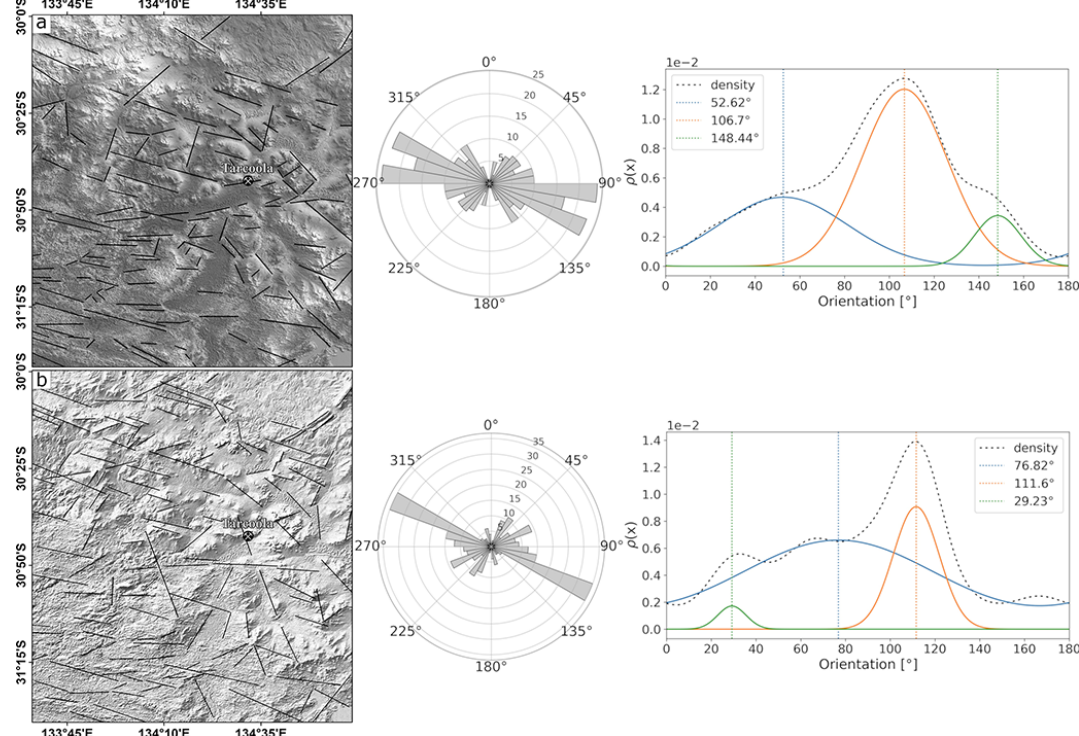
Figure 7. (a) Manually segmented lineaments observed in the unprocessed laser altimeter DEM data. To the right of the map the rose diagram showing the distribution of strike directions (bin size of 10 ◦ ) and the Gaussian model fitted to the probability density function is shown. (b) Manually segmented lineaments obtained from the laser altimeter data after edge detection filtering. We show the mean horizontal and vertical gradient components obtained via Sobel convolution filtering. To the right of the map the rose diagram shows the distribution of orientation with a bin size of 10 ◦ , and the lower plot represents the Gaussian models fitted to the probability density